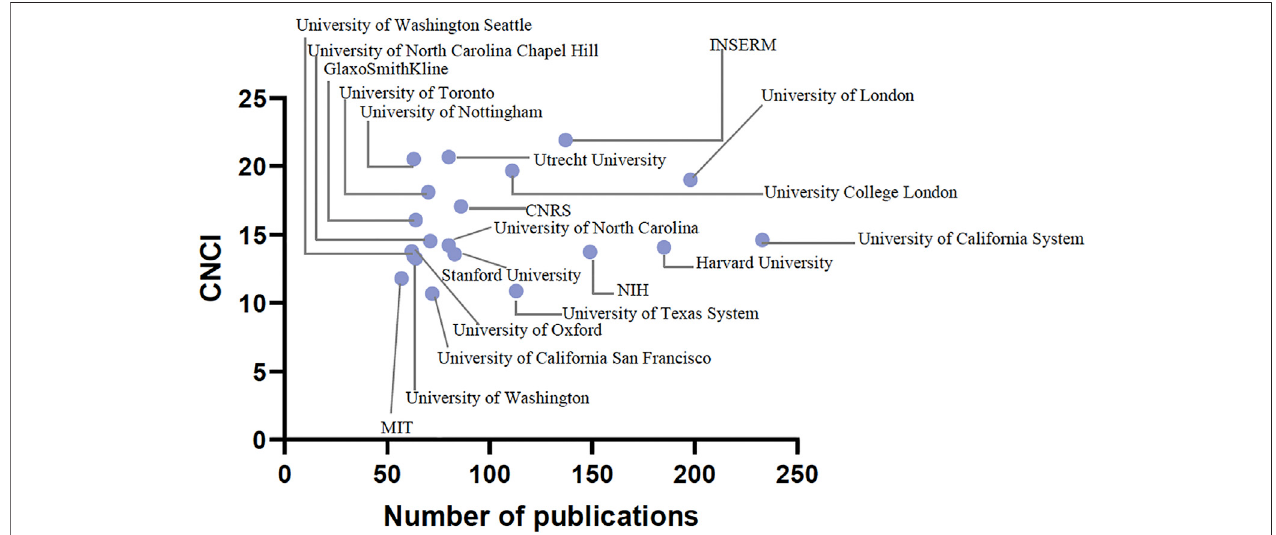
FIGURE 3 | Number of high-impact studies in pharmacology and pharmacy research and CNCI values of the top 20 institutions.